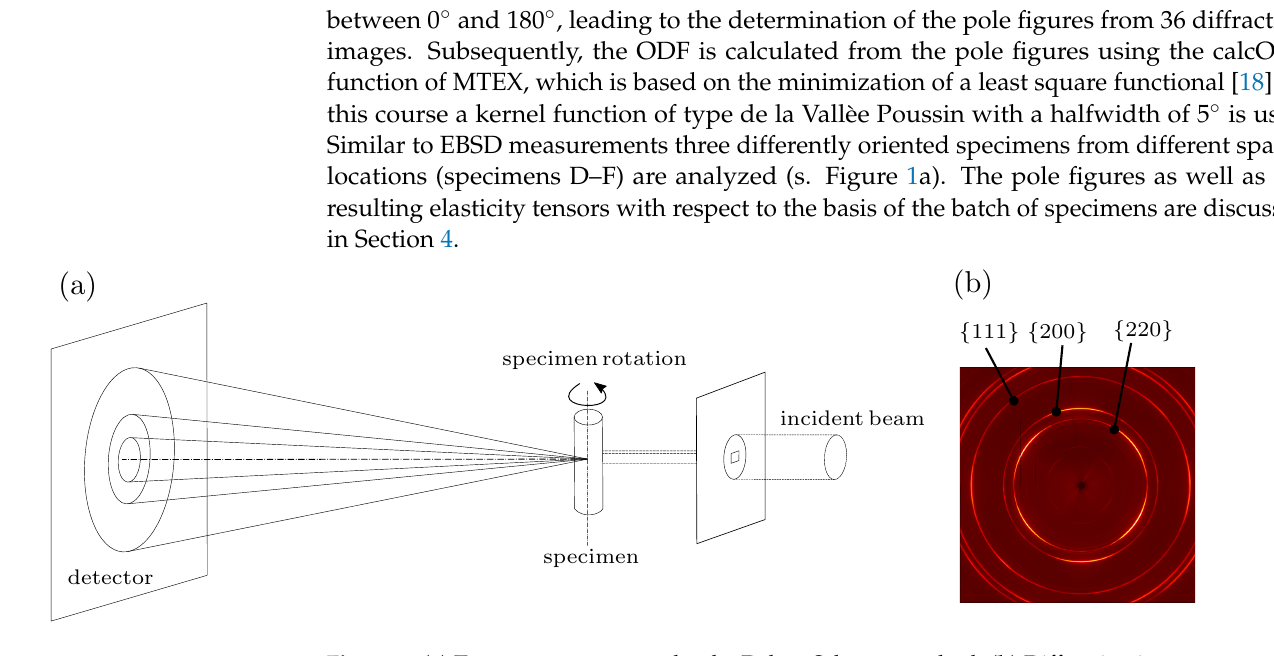
Figure 6. ( a ) Texture measurement by the Debey-Scherrer method. ( b ) Diffraction